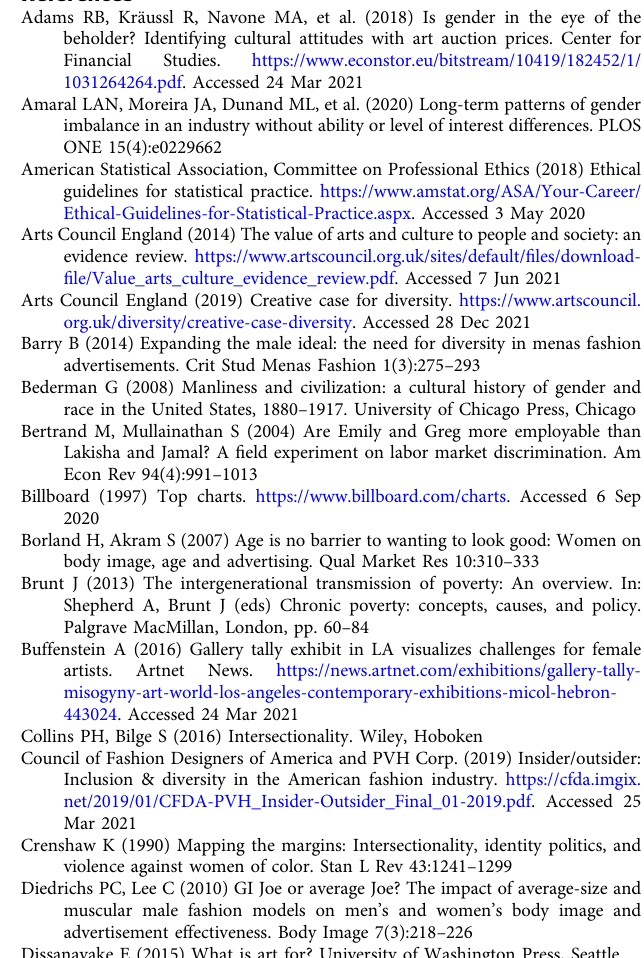
different results. Our study is also limited in the speci fi c axes of identity addressed. The American Community Survey reports not gender, but rather, a binary sex, resulting in the erasure of many gender minority groups in their data and, by extension, our own study. Moreover, while our study addresses primary, socially inferred gender and race/ethnicity, it does not address multi- racial/multi-ethnic identity, nor does it address many other important axes of identity.